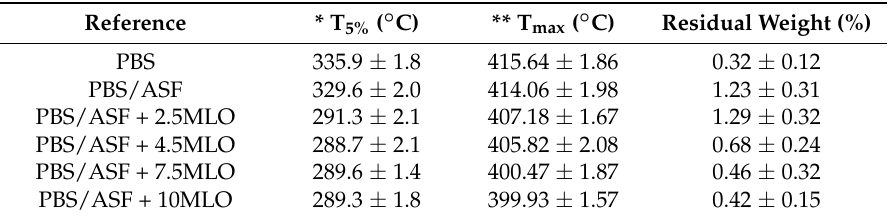
Table 4. Summary of the main thermal parameters of the degradation process of PBS/ASF with different percentage of